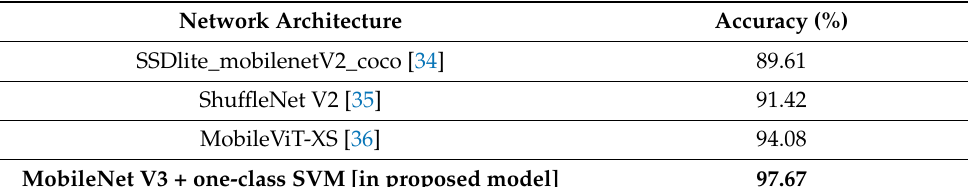
Table 6. Comparison of proposed model and state-of-the-art algorithms based on classification accuracy. Network